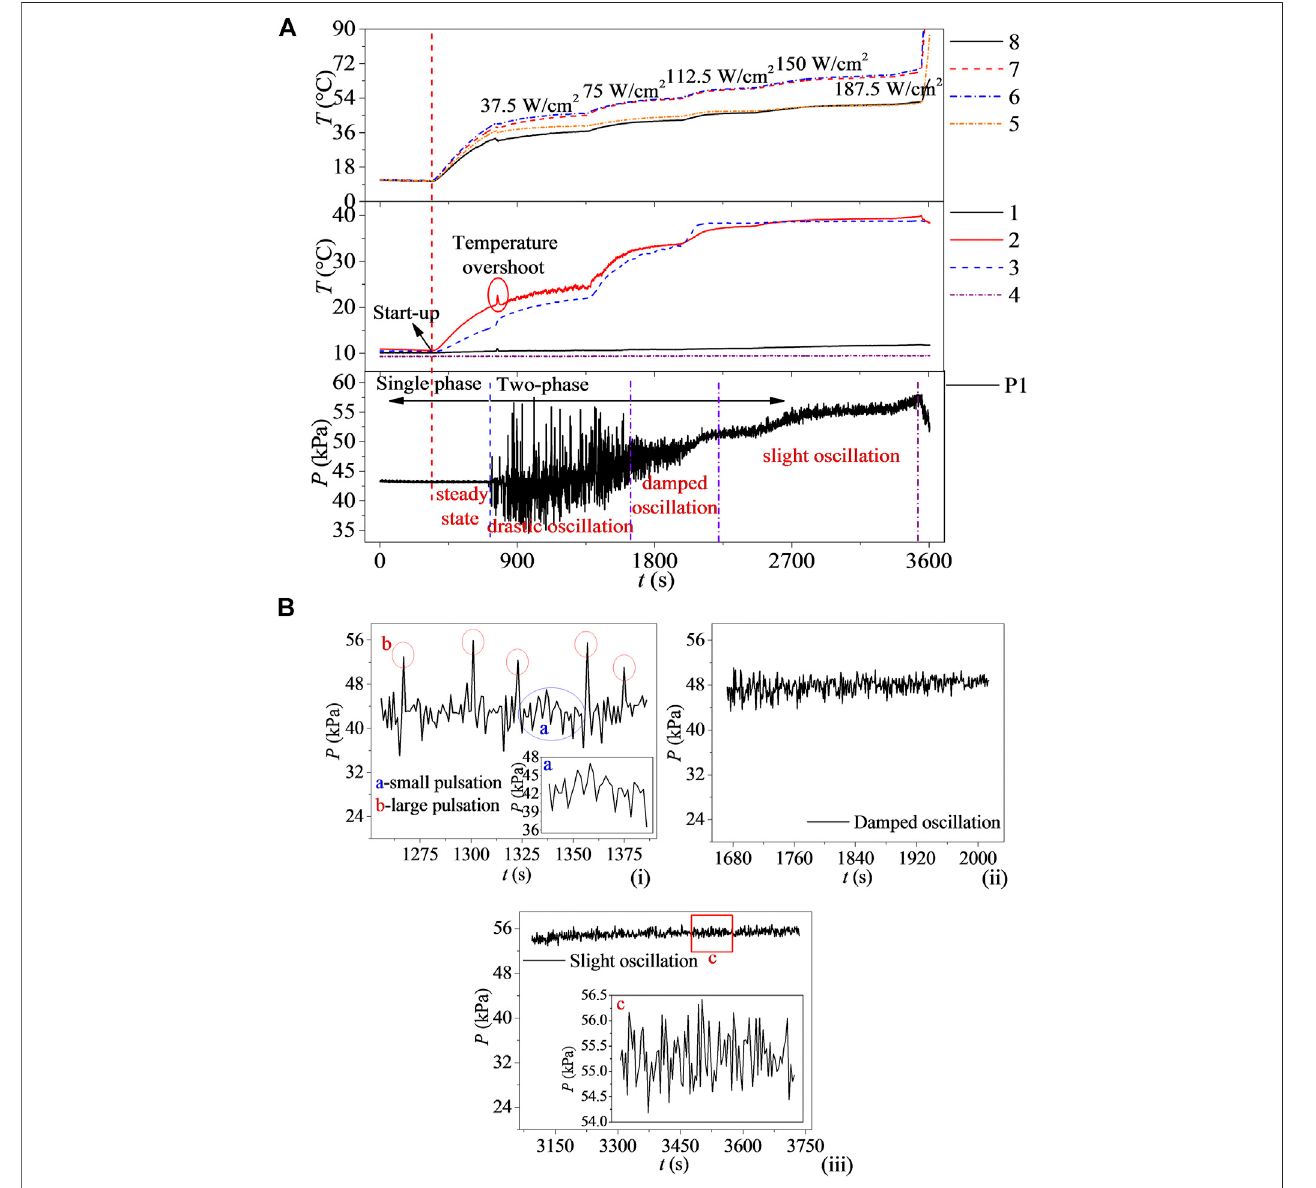
FIGURE 3 | (A) Dynamic thermal response of the MPCL system to a heat load. (B) Pressure fl uctuation of the evaporator outlet in two-phase fl ow: (i) drastic oscillation; (ii) damped oscillation; and (iii) slight